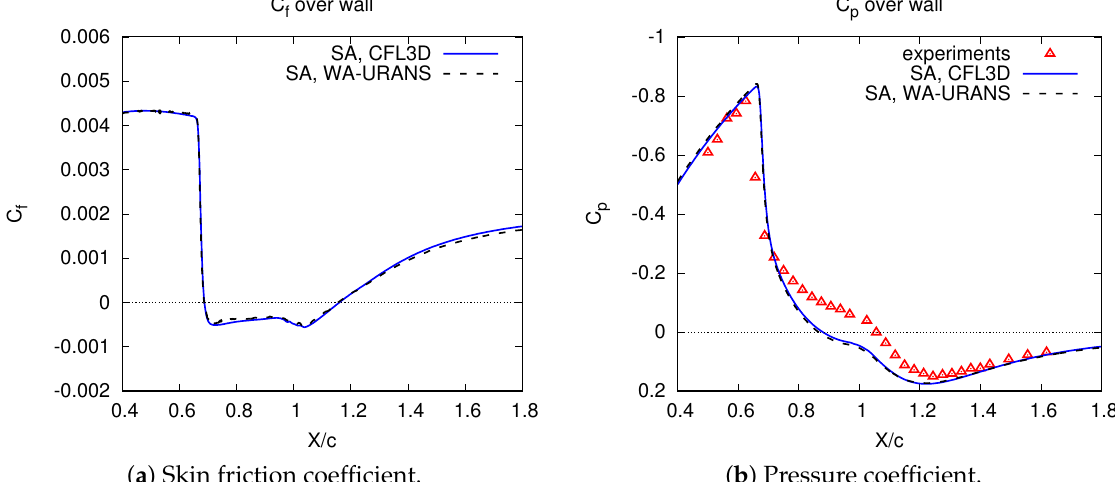
( b ) Pressure coefficient. Figure 9. WA-URANS of Bachalo-Johnson flow: skin friction and pressure coefficients over the bottom wall. Comparison is made with experimental data [63] and results by NASA CFL3D code supplied with SA model